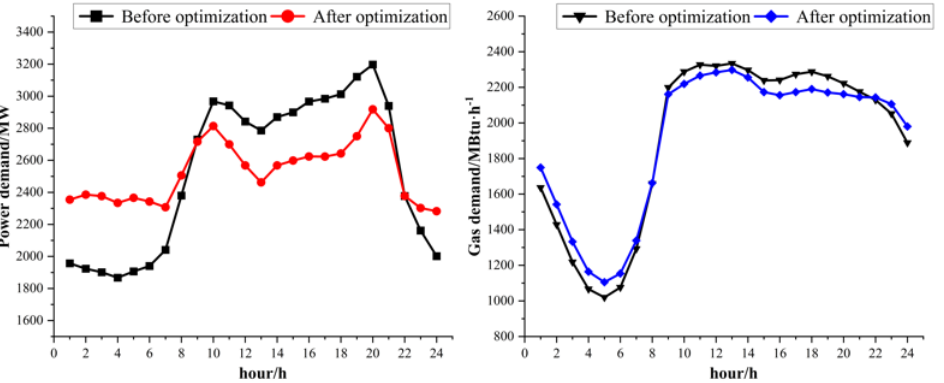
Figure 7. The carbon emission responsibility grades of each EH allocated by the Shapley value in Scenario 1.